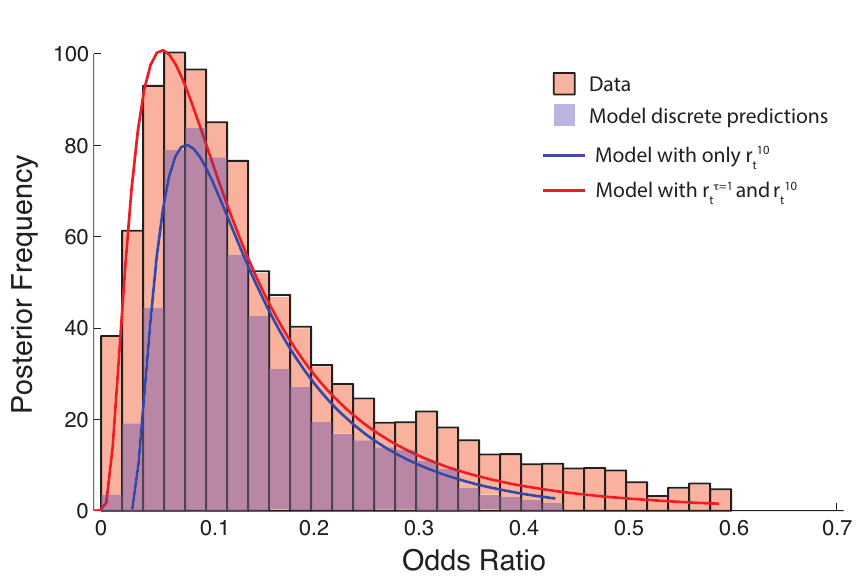
Figure 5. Data and Model predictions. The odds ratio is the ratio of the odds of a ROE change (at least 10% of change) in the year following a year with at least one hurricane to the odds of a ROE change in the year following a year without a hurricane.